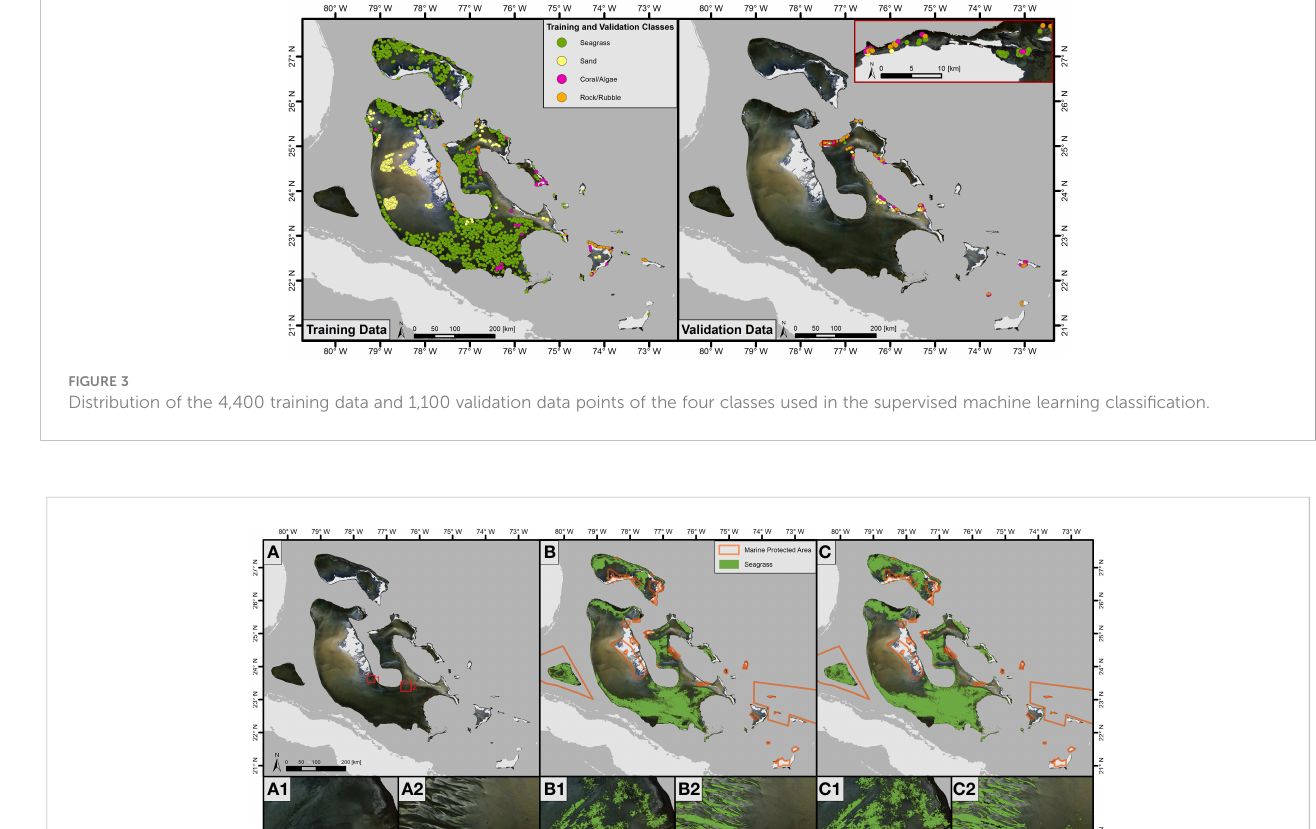
FIGURE 4 False-color Sentinel-2 composite (Bands 3-2-1) (A) overlaid with the mapped minimum (B) and maximum (C) seagrass extent, and Marine Protected Areas across The Bahamas. The location of the zoomed-in insets (A1) - (C2) is shown in panel (A) .